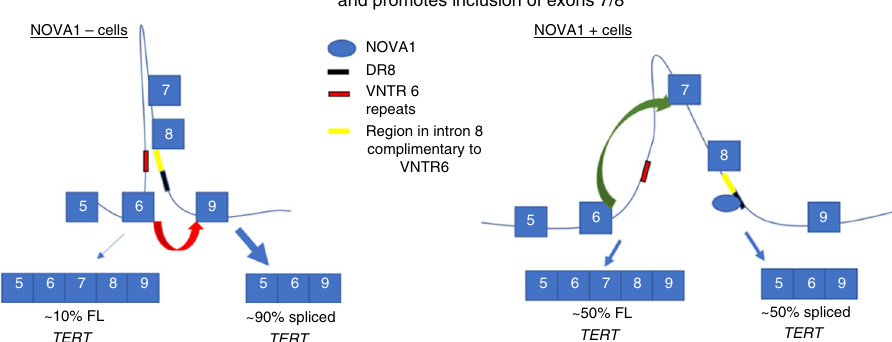
Fig. 6 NOVA1 binds to a deep intronic sequence in hTERT DR8 and acts as a splicing enhancer to promote the inclusion of exons 7/8 and greater levels of full-length hTERT mRNAs. a Linear model depicting NOVA1 binding to TERT DR8 promoting the inclusion of exons 7/8. b Alternative model of NOVA1 promoting full-length TERT considering RNA:RNA pairing/RNA secondary structure of TERT